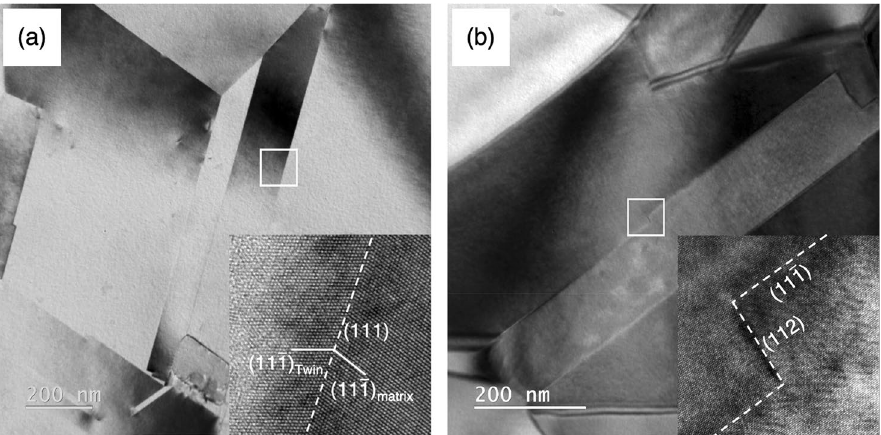
Figure 6. Two sets of BF TEM and HRTEM images show two representative boundary structures of two Σ3{111} twin boundaries in an undeformed sample. ( a ) The atomic structure of the region marked by a white square is an atomistically coherent and flat twin boundary. ( b ) The atomic structure of the region marked by white square represents a 5 nm (112) incoherent twin